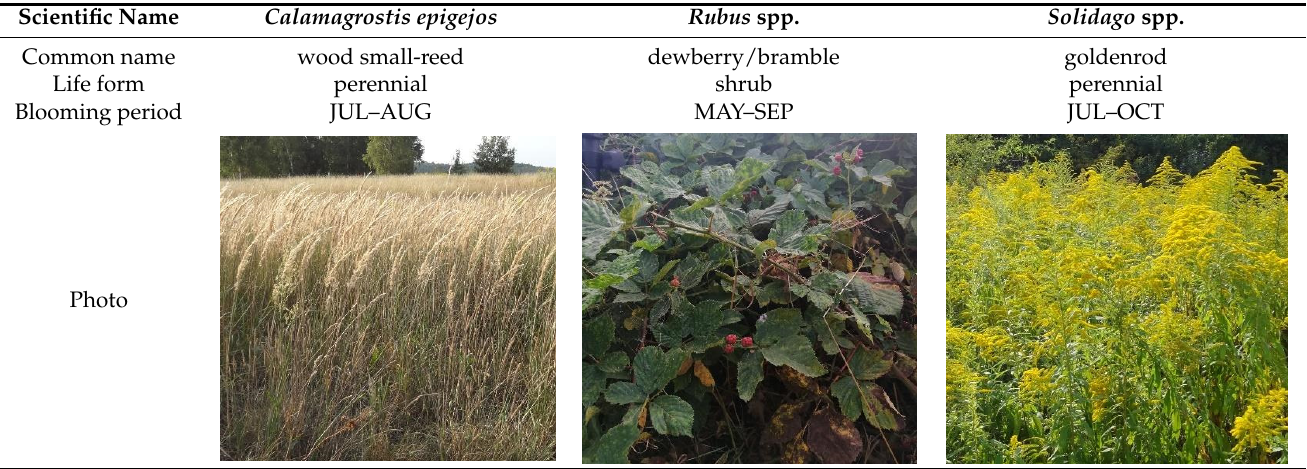
Table 1. Research objects of the study. From left to right photos show specimens of Calamagrostis epigejos , Rubus spp. and Solidago spp. (photos taken by Anita Sabat-Tomala).